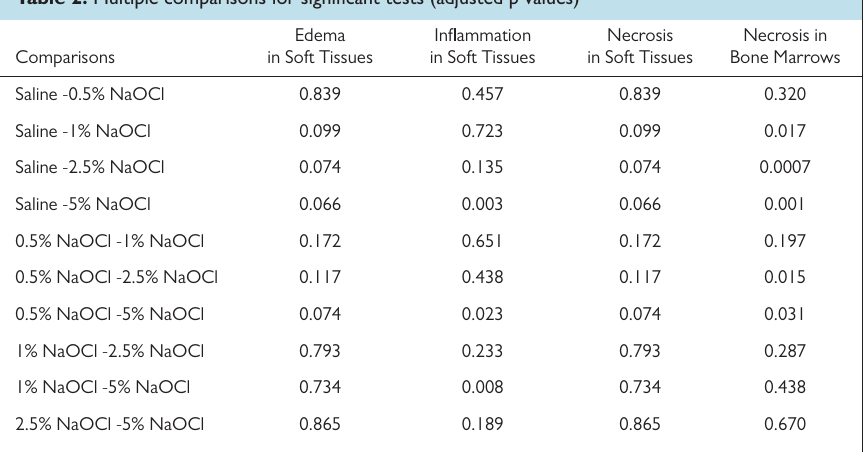
Table 2. Multiple comparisons for significant tests (adjusted p values)